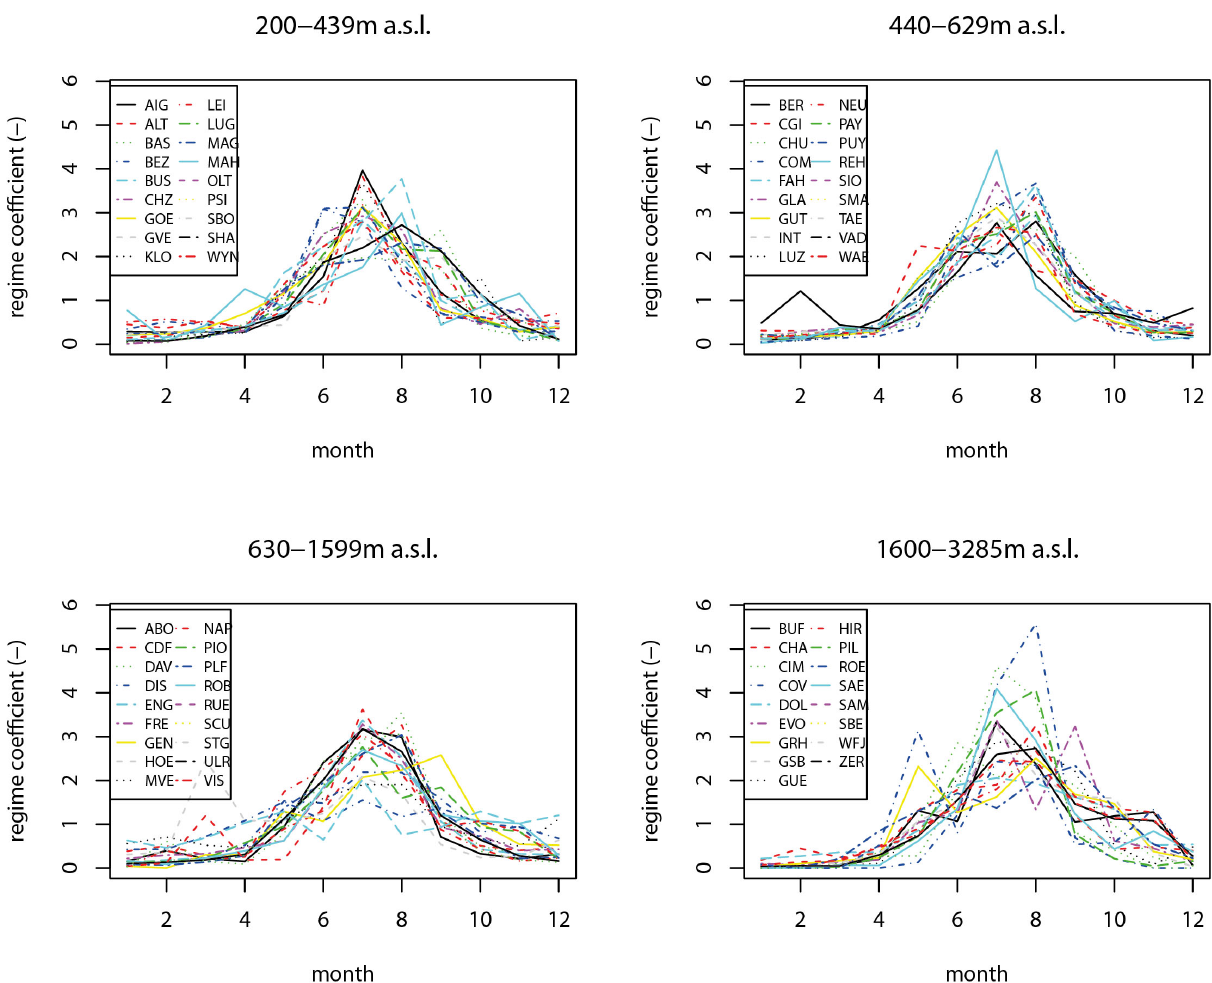
Fig. 7. Rainfall erosivity regimes grouped by